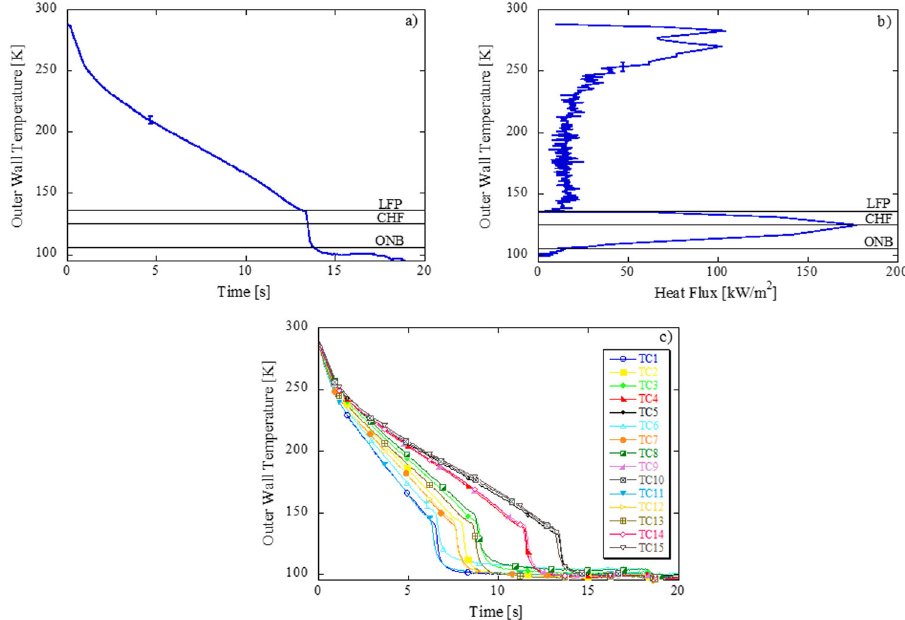
Fig. 1 Test F2 (Flight_Day1_2, continuous fl ow, 550 kPa source pressure, 67324 Re, bare tube surface, 0.05 G level (g/g0)). a Chilldown curve based on average exit wall temperature, b Boiling curve based on average exit wall temperature, c Chilldown curve of all